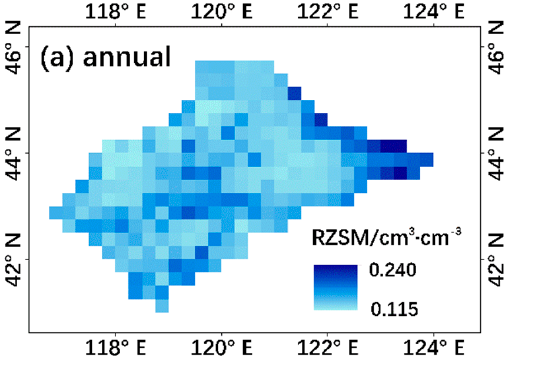
Figure 7. Average RZSM produced by the regional SMAR model from 2013 to 2020 during ( a ) the whole year and ( b ) the growing season (April to October). The relative RZSM is transformed to volumetric root-zone soil content (cm 3 ·cm − 3 ) with root-zone porosity data.